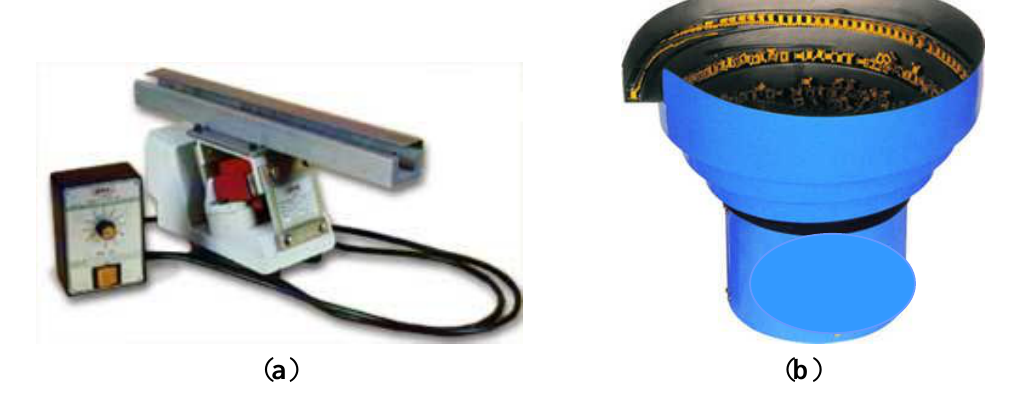
Figure 1. The two main types of vibrating feeders: ( a ) linear feeder; ( b ) bowl